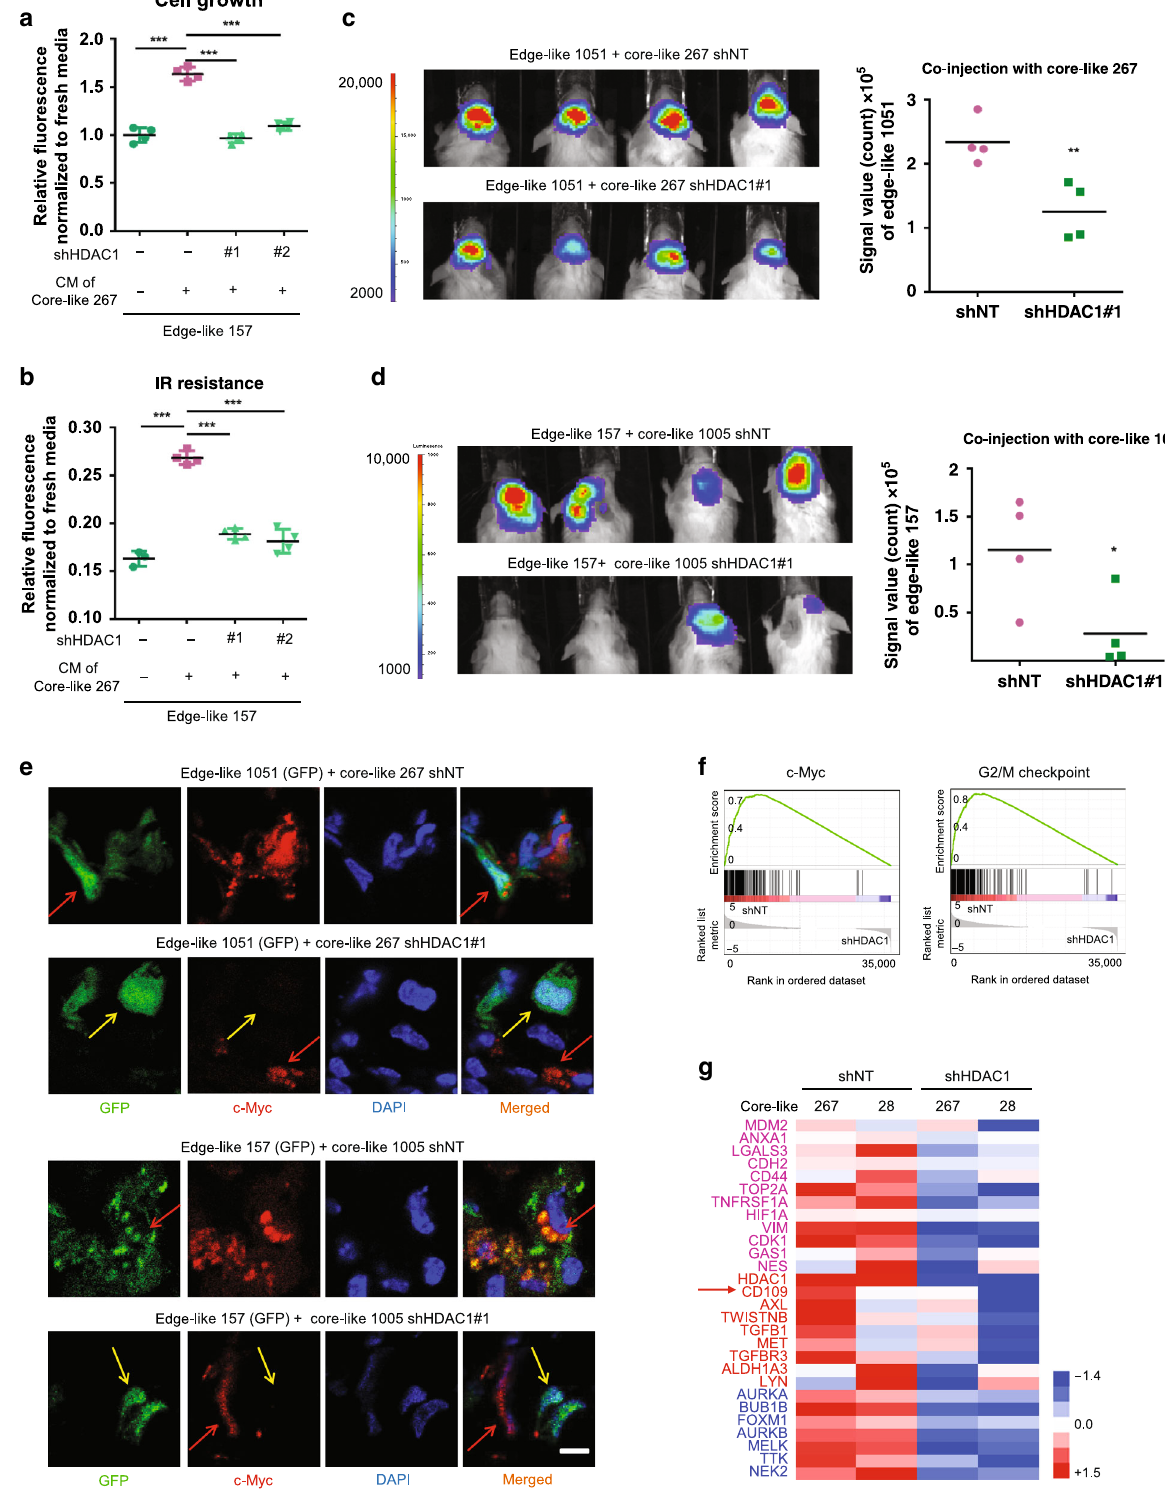
transcriptional factor for CD109 expression 11 and that analysis of our matched longitudinal GBM samples indicated that C/EBP β was signi fi cantly higher in CD109 up recurrence group (Supple- mentary Fig. 5b), we examined whether occupancy of C/EBP β at the promoter region of CD109 is under the control of HDAC1 in core-like spheres. ChIP-PCR showed that shHDAC1 diminished the binding of C/EBP β in two of three CD109 promoter regions in